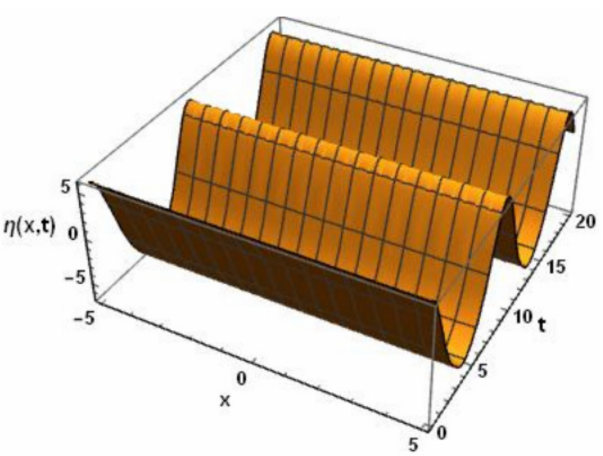
Figure 23. The perturbed surface solution as given in Equation (70) in three